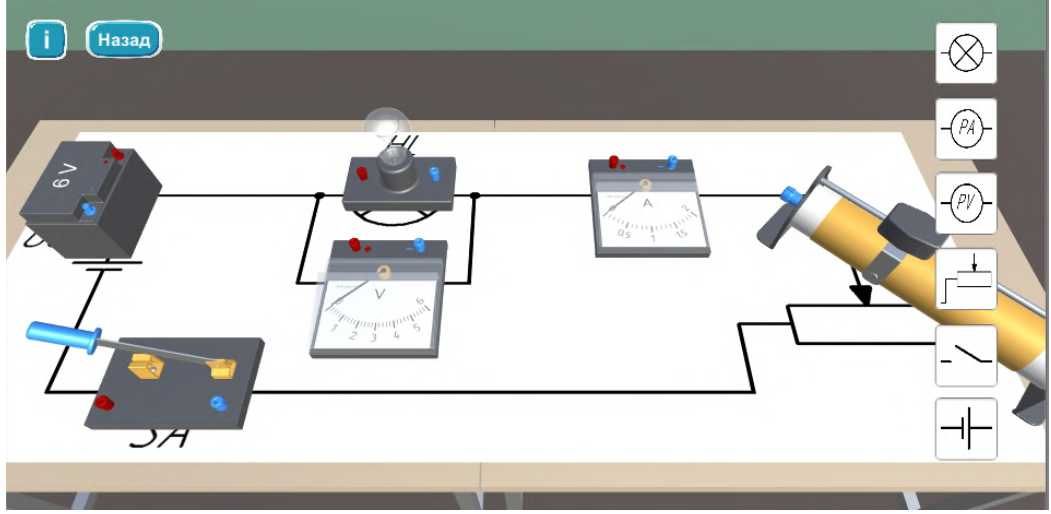
Figure 7: Presentation of paper [82].